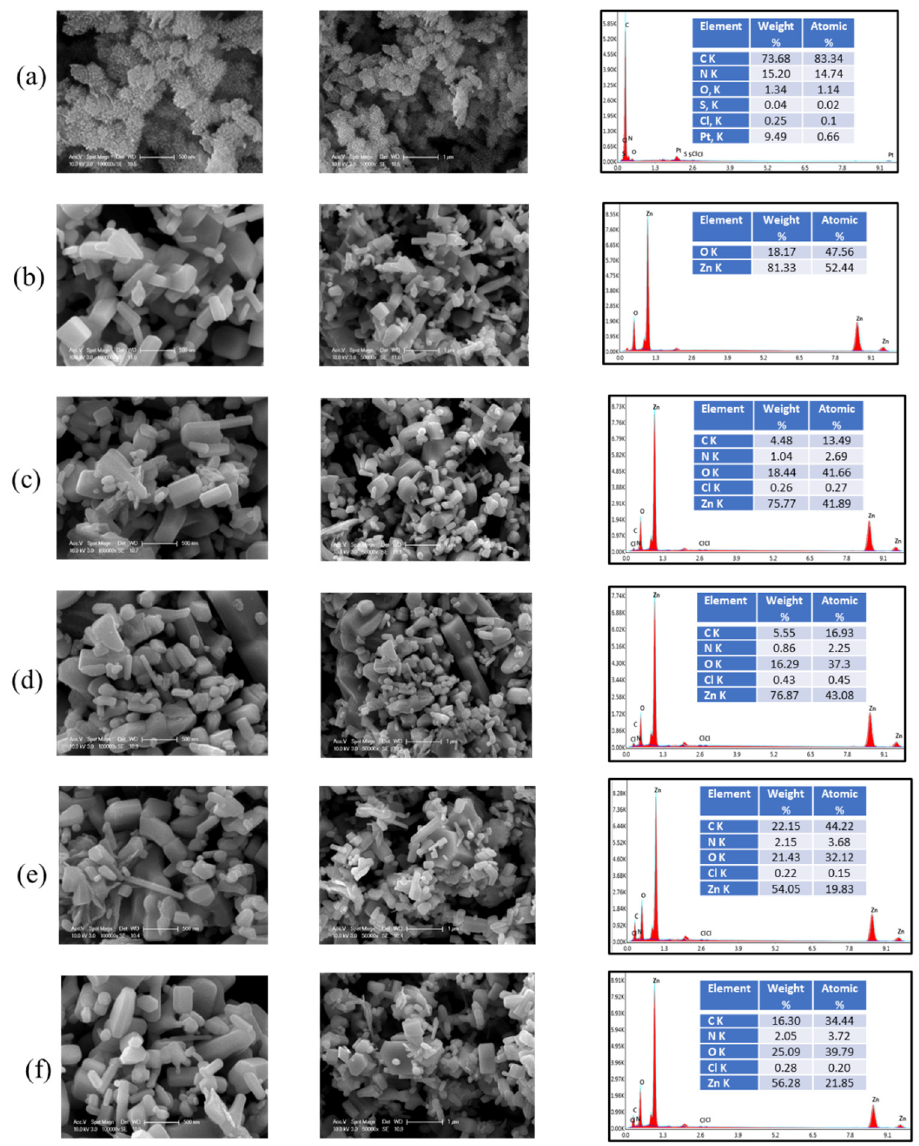
Figure 6. Scanning Electron Microscopy (SEM) images (left) ×50,000, (right) ×100,000 and EDAX elemental analysis ( a ) PANI-EB, ( b ) ZnO, ( c ) PZS-1, ( d ) PZS-3, ( e ) PZS-6 and ( f ) PZS-9.